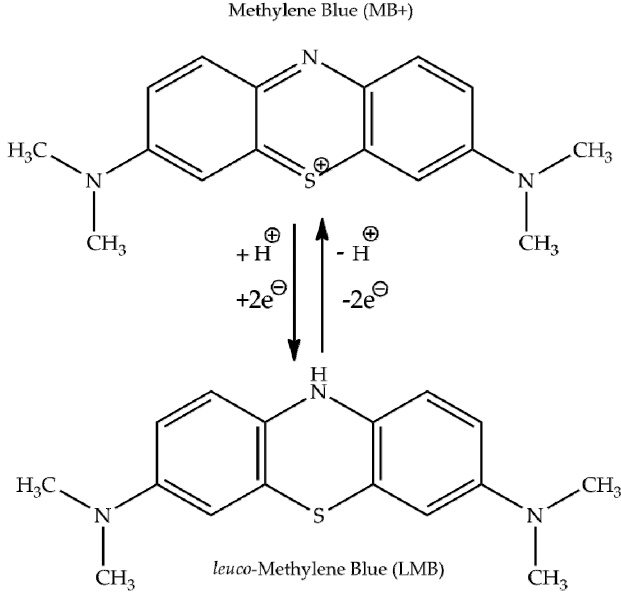
Figure 7. Molecular formulae for methylene blue and its leuco-form. At low in vivo concentrations, methylene blue and leuco-methylene blue are in equi- librium, such that they form a reversible reduction/oxidation system.